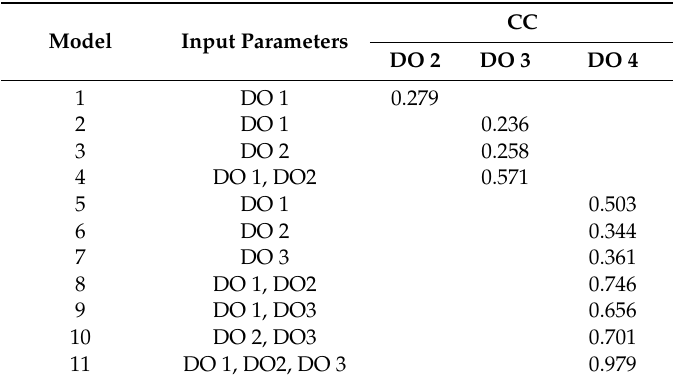
Table 7. Results for scenario